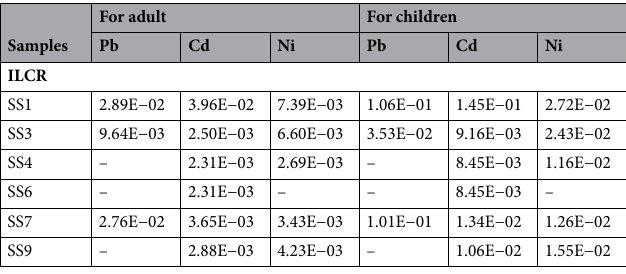
Table 10. ILCR value of trace element presents in the water sample.